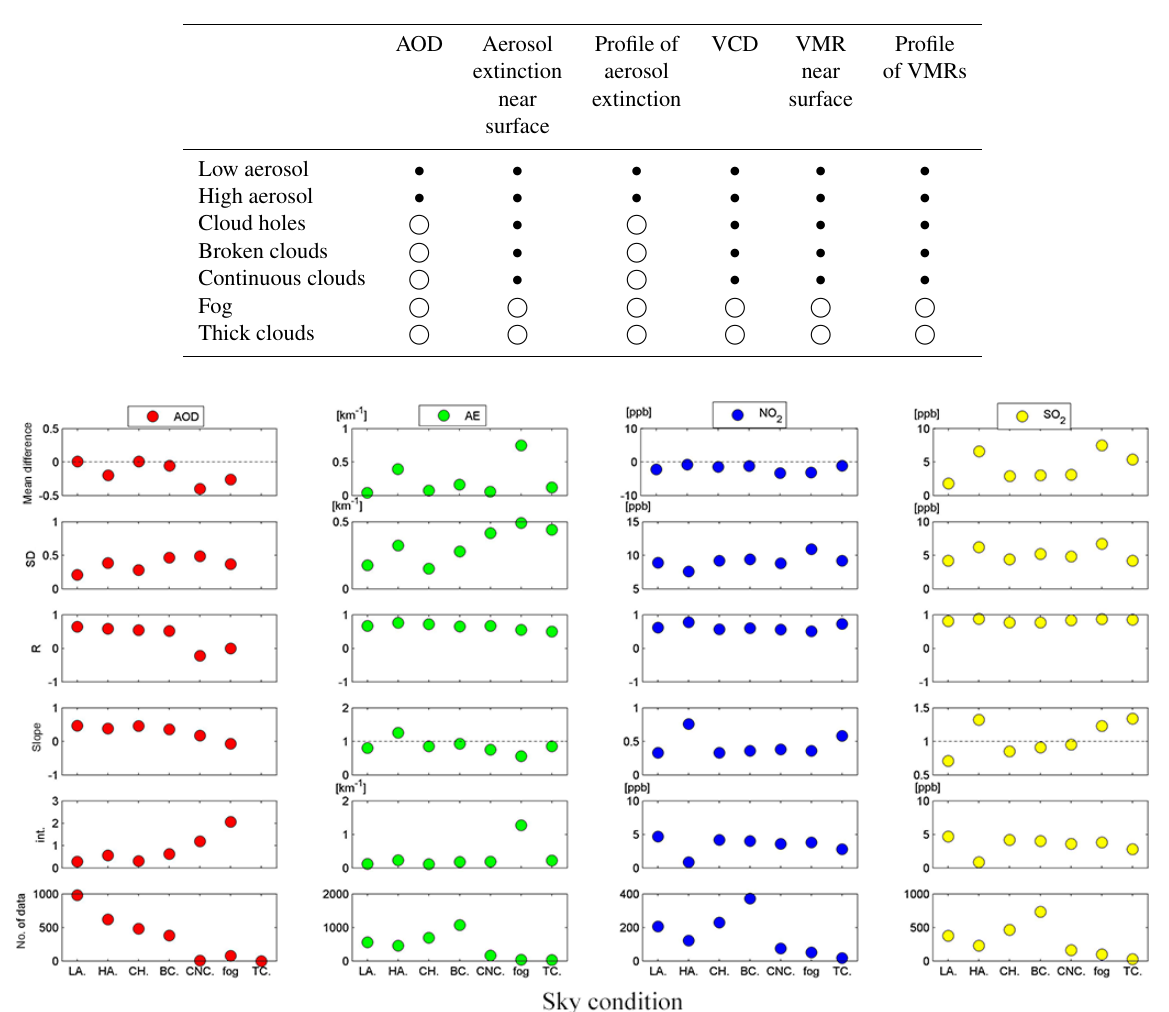
Table 3. Filter scheme of aerosol and trace gas results derived from MAX-DOAS observations. Filled circles ( • ): use of measurement is recommended; Open circles ( (cid:13) ): use of measurement is not recommended.